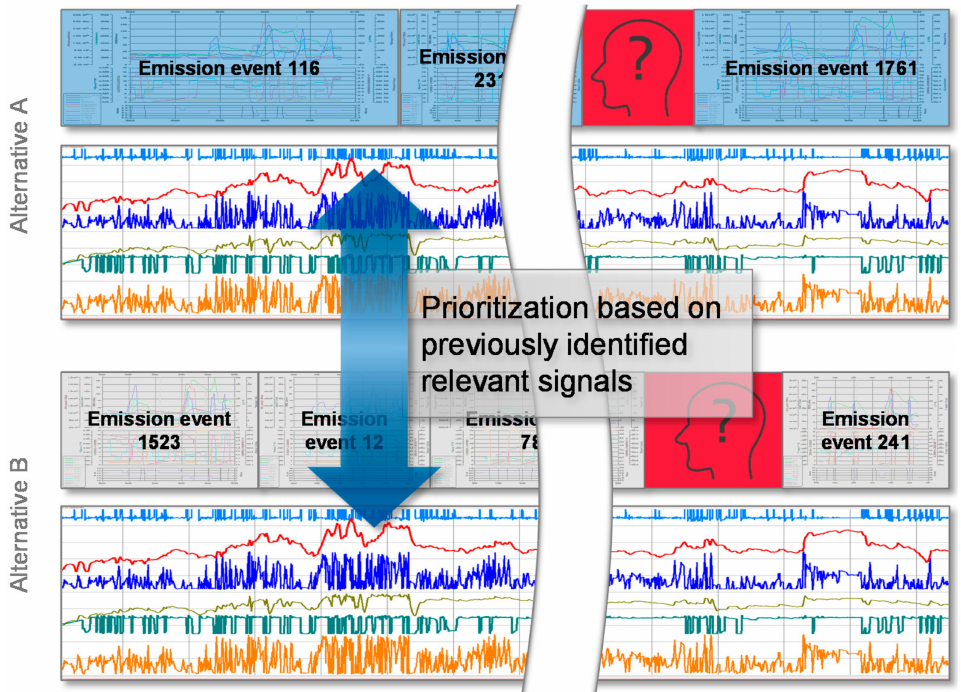
Figure 9. Schematic procedure for quantification of statistical data certainty and identification of missing